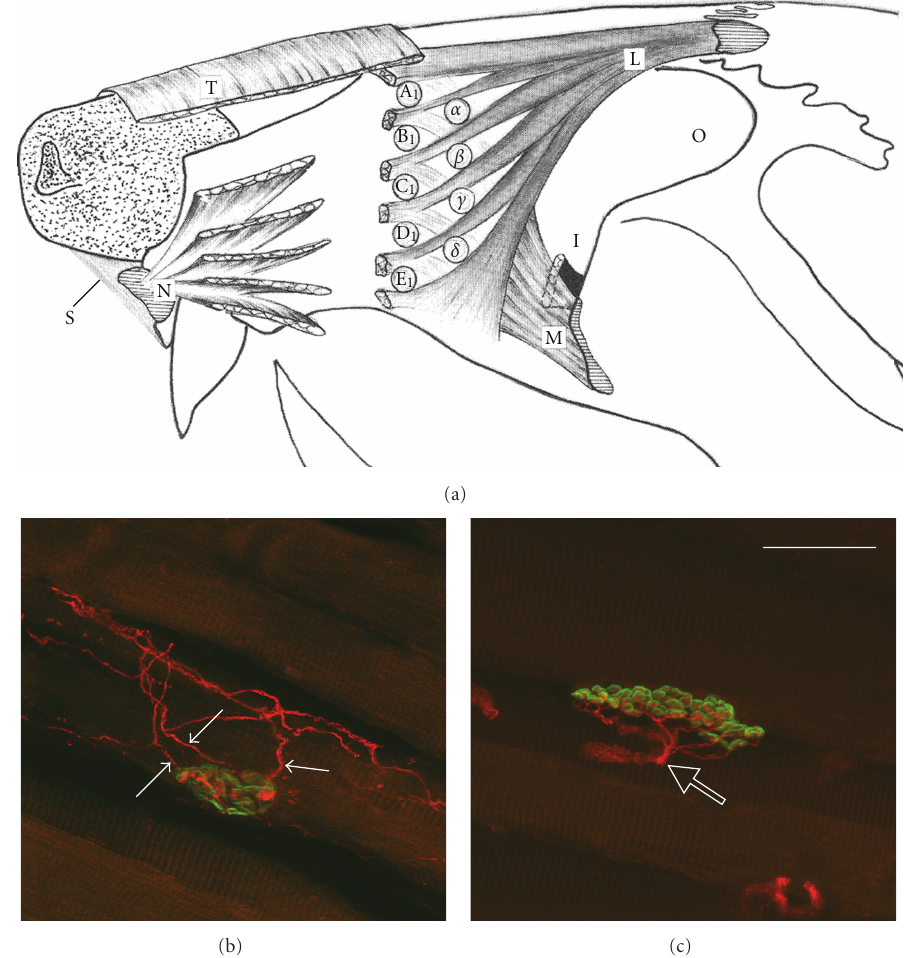
Figure 5: (a) Schematic drawing of the extrinsic vibrissae muscles. α - δ : the four caudal hair follicles, the muscles slings of which “straddle” the five vibrissae rows (A)–(E); T–m. transversus nasi; L–m. levator labii superioris; N–m. nasalis; M–m. maxilolabialis; O–orbit; S–septum intermusculare. (b) and (c) are the superimposed stacks of confocal images of end-plates in LLS muscles of intact and surgically treated rats visualized by staining of the motor end-plates with Alexa Fluor 488 α -bungarotoxin (green fluorescence) and immunostaining of the intramuscular axons for neuronal class III β -tubulin (Cy3 red fluorescence). (b) and (c) show examples of a polyinnervated and a monoinnervated end-plate, respectively. Three axonal branches ( arrows in (b)) reach the boundaries of the polyinnervated end-plate delineated by the alpha-bungarotoxin staining. In contrast, the monoinnervated end-plate is reached by a single axon ( empty arrow in (c)) with several preterminal rami. In both examples, the whole end-plates are within the stack of confocal images. Scale bar shown in (c) indicates 125 μ m (adopted from